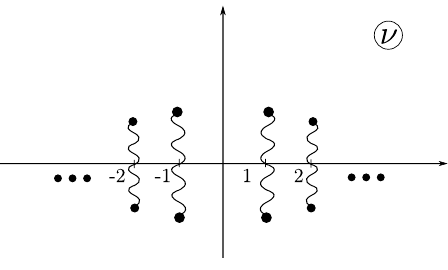
Figure 1 . This picture shows the branch cut structure of the function u ( q; (cid:23) ). Each cut near (cid:23) = n is identi(cid:12)ed with the cut near (cid:23) = (cid:0) n . As the result of this identi(cid:12)cation we obtain an in(cid:12)nite-genus